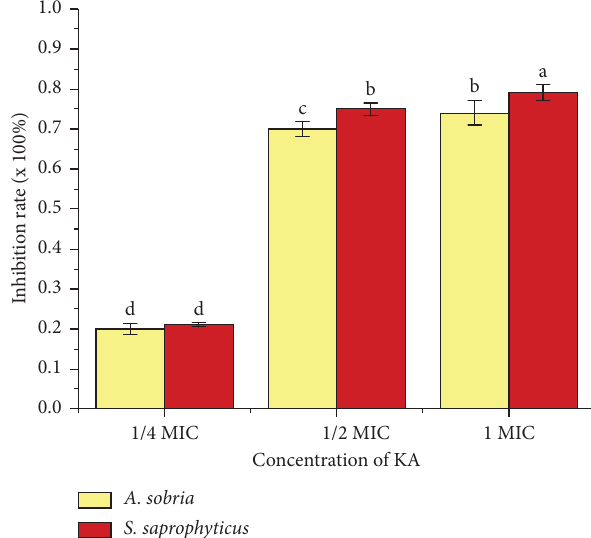
Figure 5: Inhibition efect on EPS of A. sobria and S. saprophyticus after KA treatment at diferent densities at 30 ° C for 24h. Values are exhibited as the percentage of excretion of EPS. Te diferent lowercase letters represent signifcant diferences ( P < 0.05).